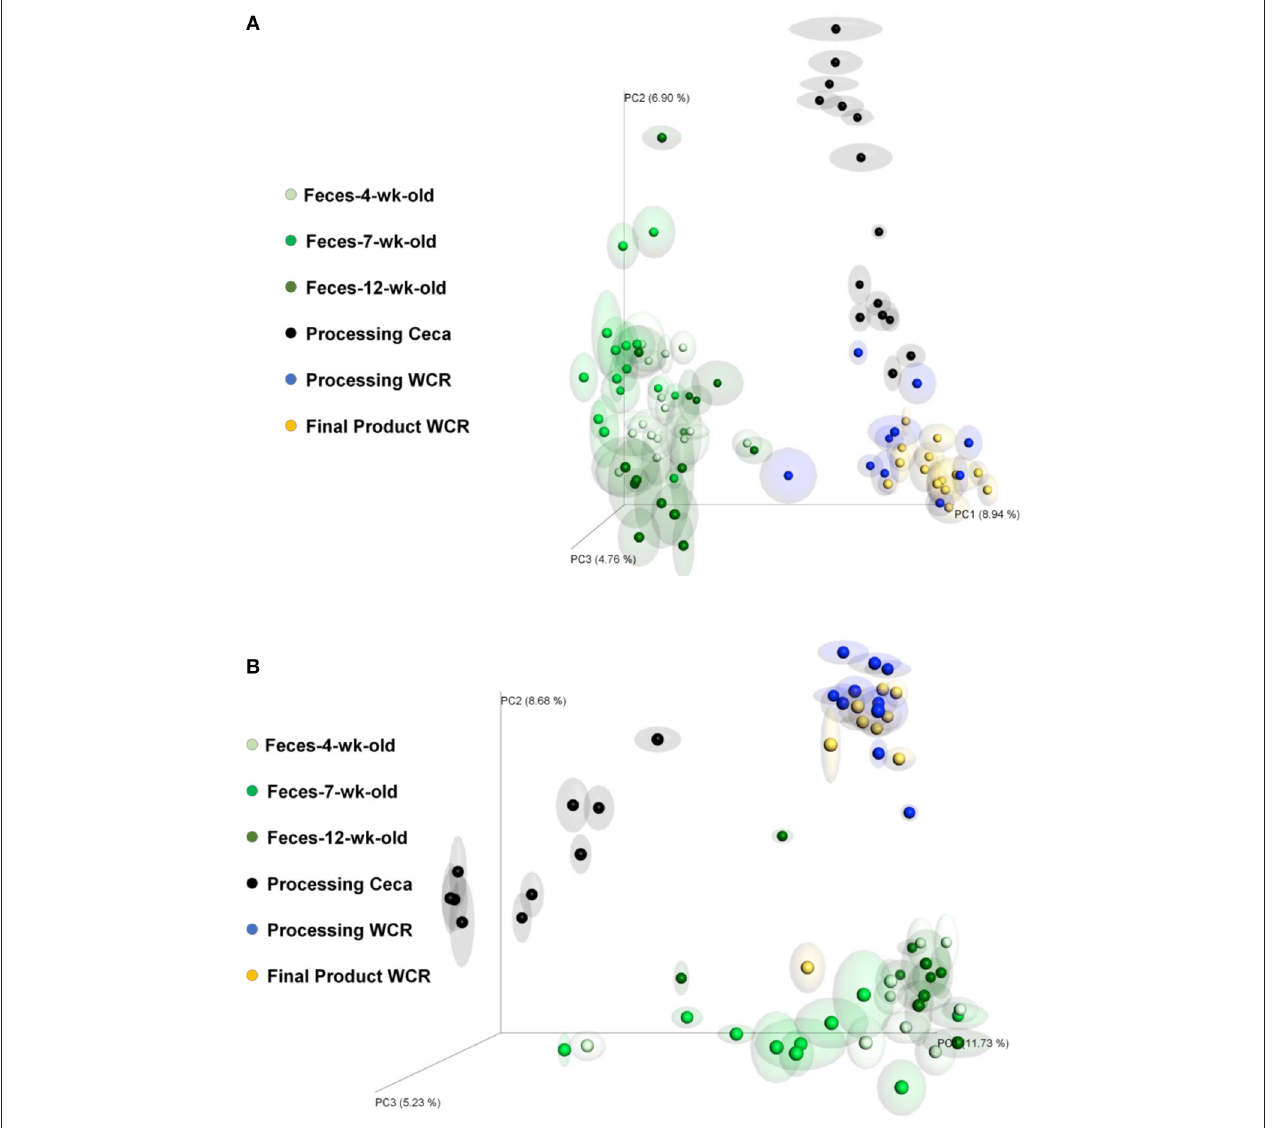
FIGURE 3 | Jackknifed 3D principal coordinate analysis (PCoA) of β -diversity of pasture-raised chicken fed different diets using unweighted UniFrac distances. (A) Samples from birds in the Soybean Diet ( P = 0.001); (B) Samples from birds in the Soy-Free Diet ( P = 0.001). Halos around the data points represent 95% confidence